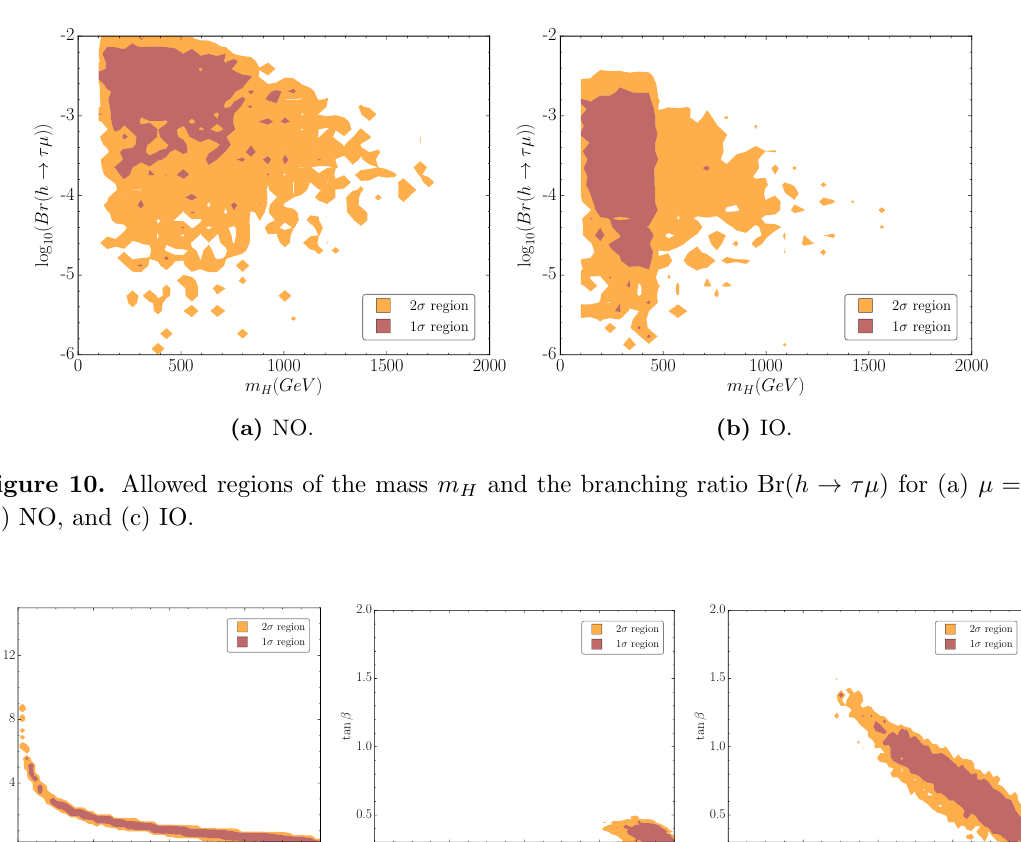
Figure 11. Allowed regions of the mixing angles sin (cid:11) and tan (cid:12) for (a) (cid:22) = 0, (b) NO, and (c)